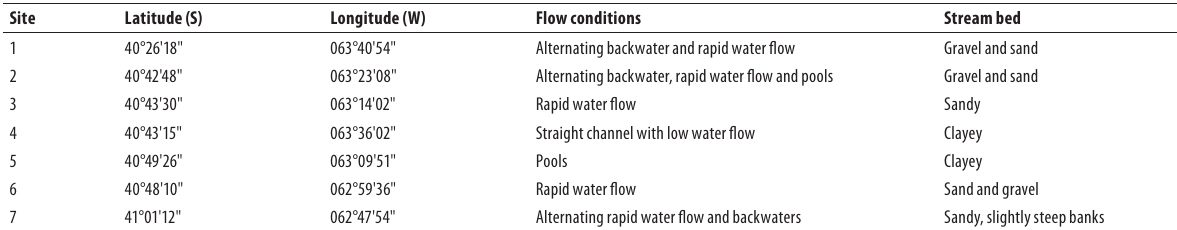
Table 1. List of sampling sites on the lower course of the Negro river drainage and environmental